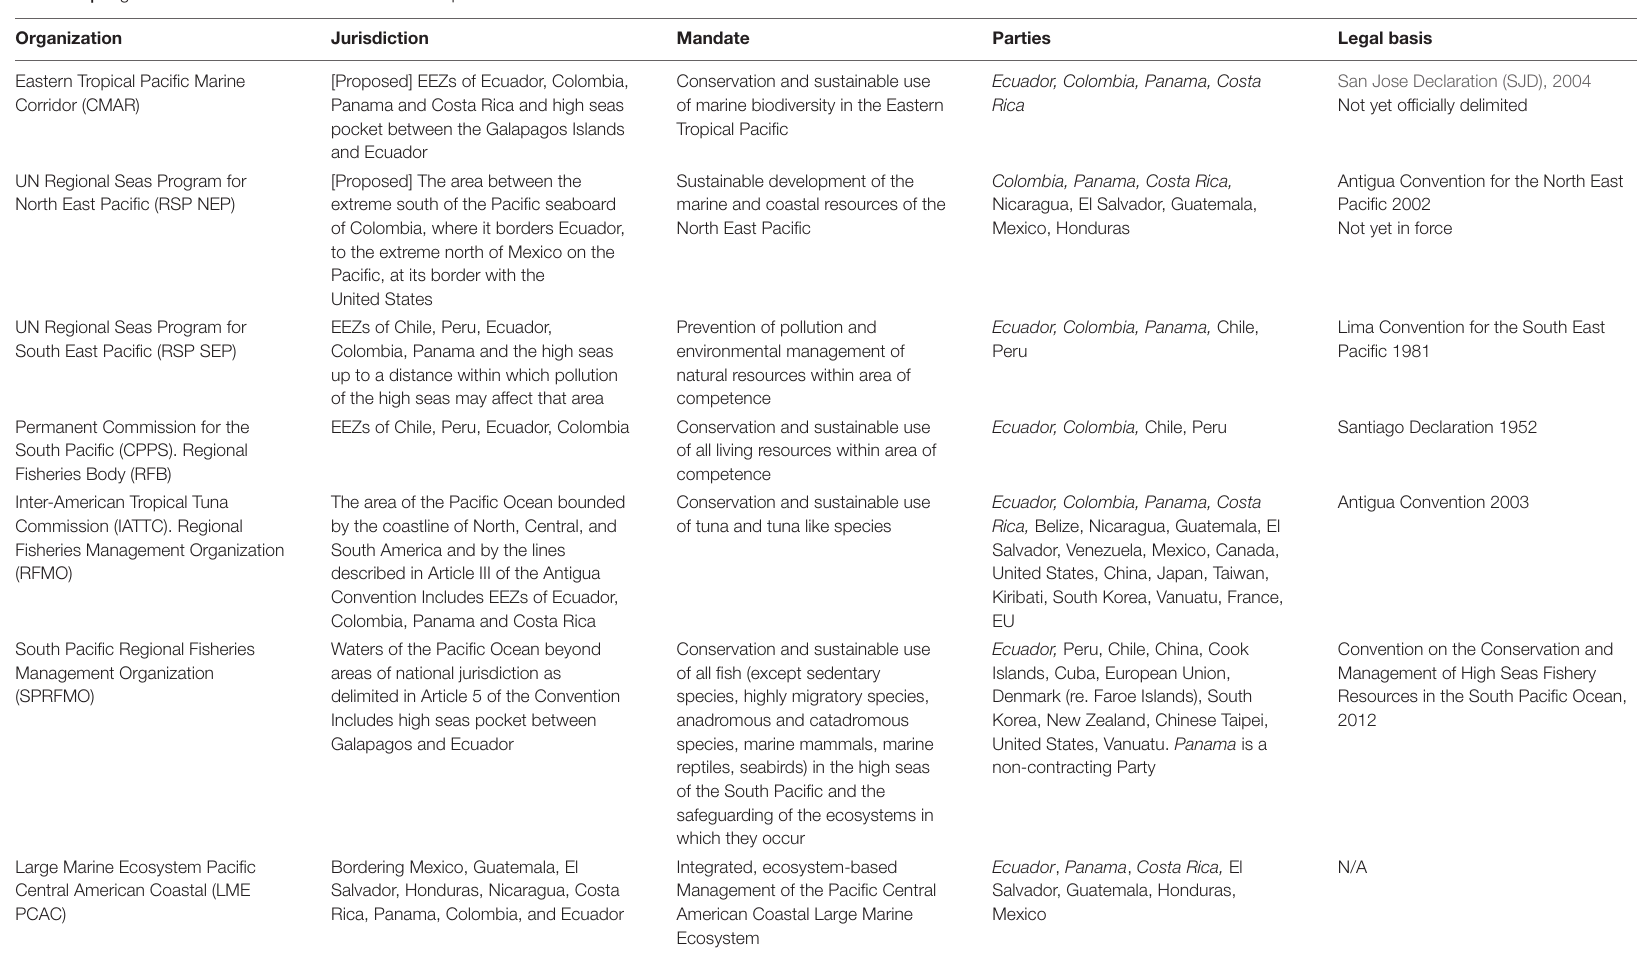
TABLE 1 | Regional Ocean Governance in the Eastern Tropical